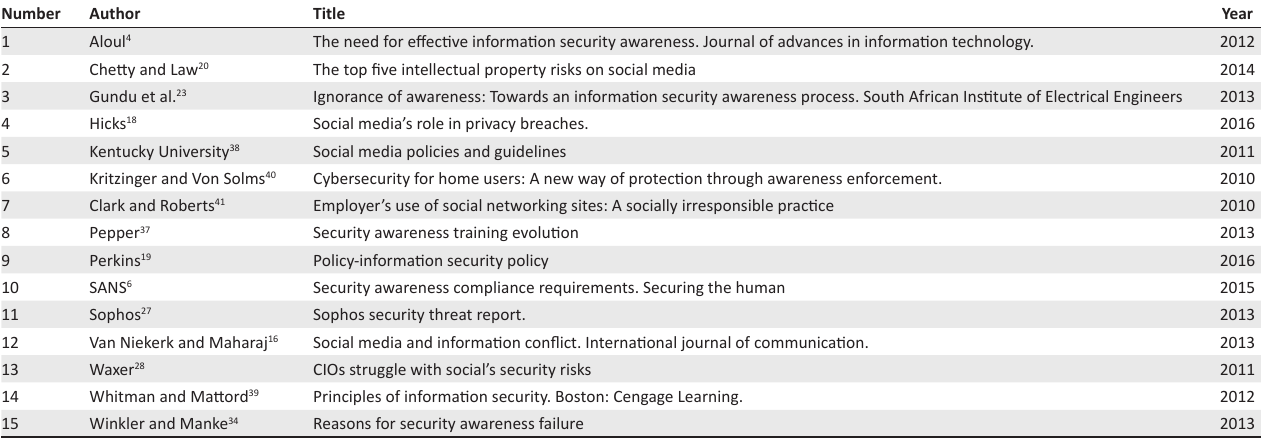
TABLE 1-A1: List of 15 studies that are included in the research and the identified topics after the thematic